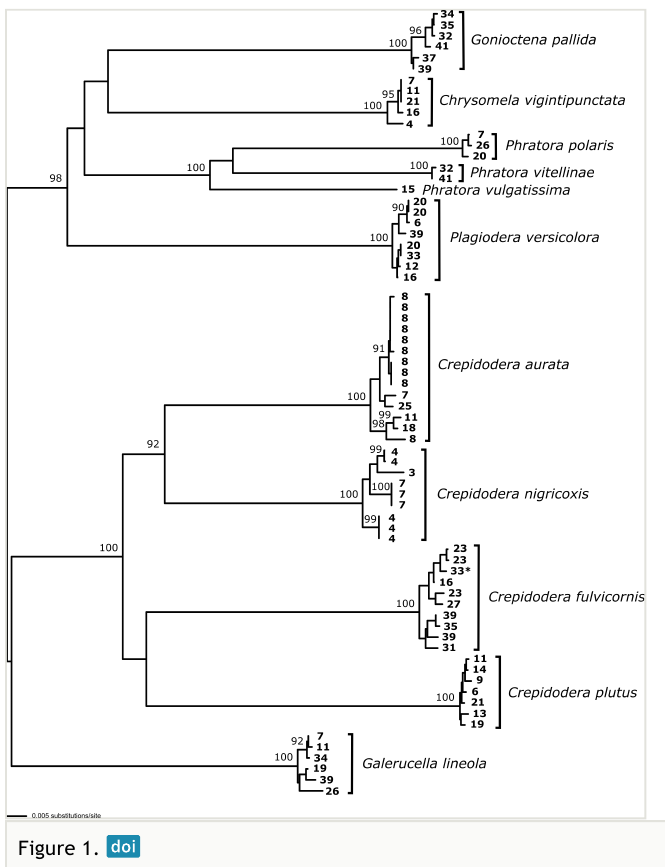
Figure 1. DNA analysis (NJ tree) using COI and cytB sequences generated in this study. Node support shown only for nodes ≥ 90% bootstrap